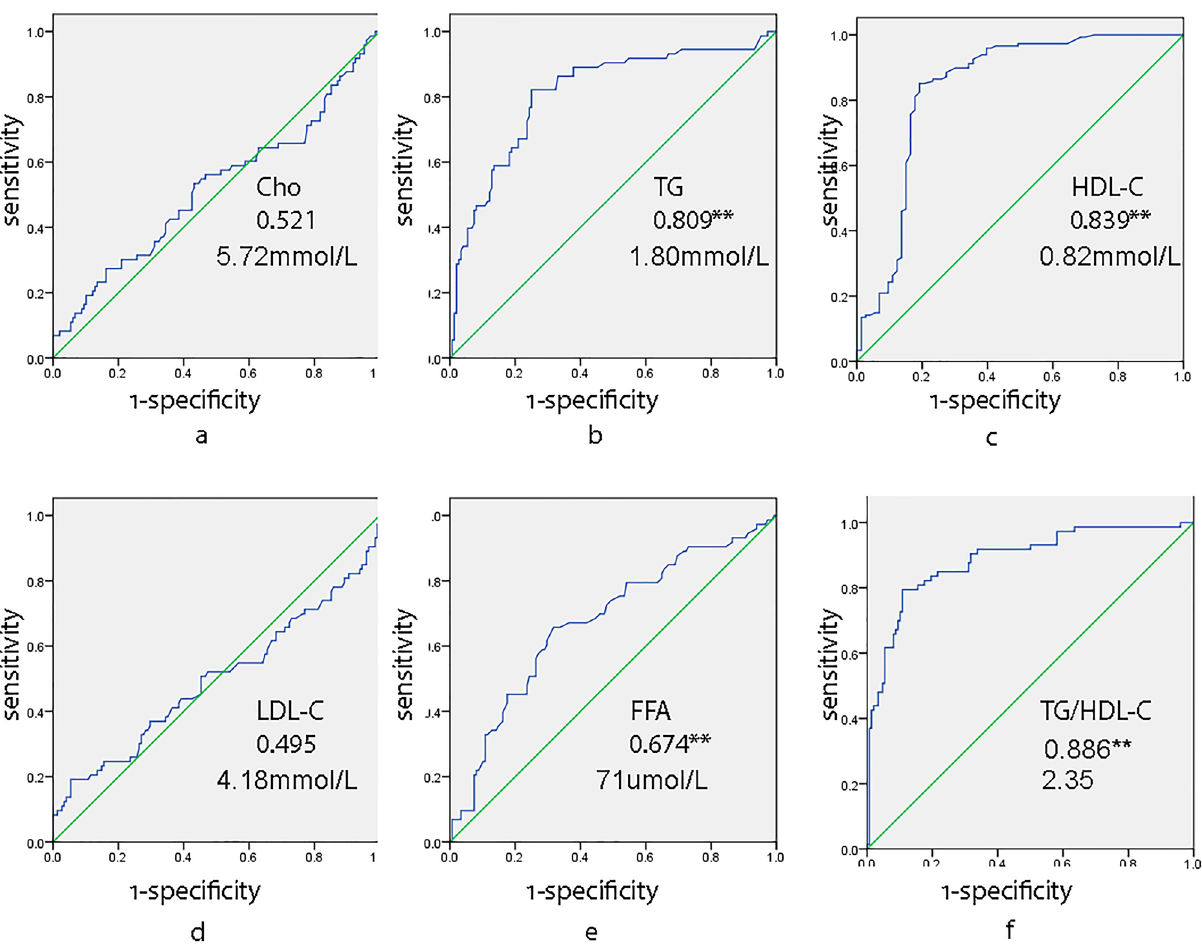
Figure 3. Receiver operating characteristic (ROC) curves of dyslipidemia and TG/HDL-C ratio for diagnosis of severe DILI. TG triglyceride, Cho cholesterol, LDL-C low-density lipoprotein cholesterol, HDL-C high-density lipoprotein cholesterol, FFA free fatty acid, DILI drug induced liver injury. ( a ) AUC and cut-off value of Cho for diagnosis of severe DILI; ( b ) AUC and cut-off value of TG for diagnosis of severe DILI; ( c ) AUC and cut-off value of HDL-C for diagnosis of severe DILI; ( d ) AUC and cut-off value of LDL-C for diagnosis of severe DILI; ( e ) AUC and cut-off value of FFA for diagnosis of severe DILI; ( f ) AUC and cut-off value of TG/HDL-C ratio for diagnosis of severe DILI. **P ≤ 0.01.